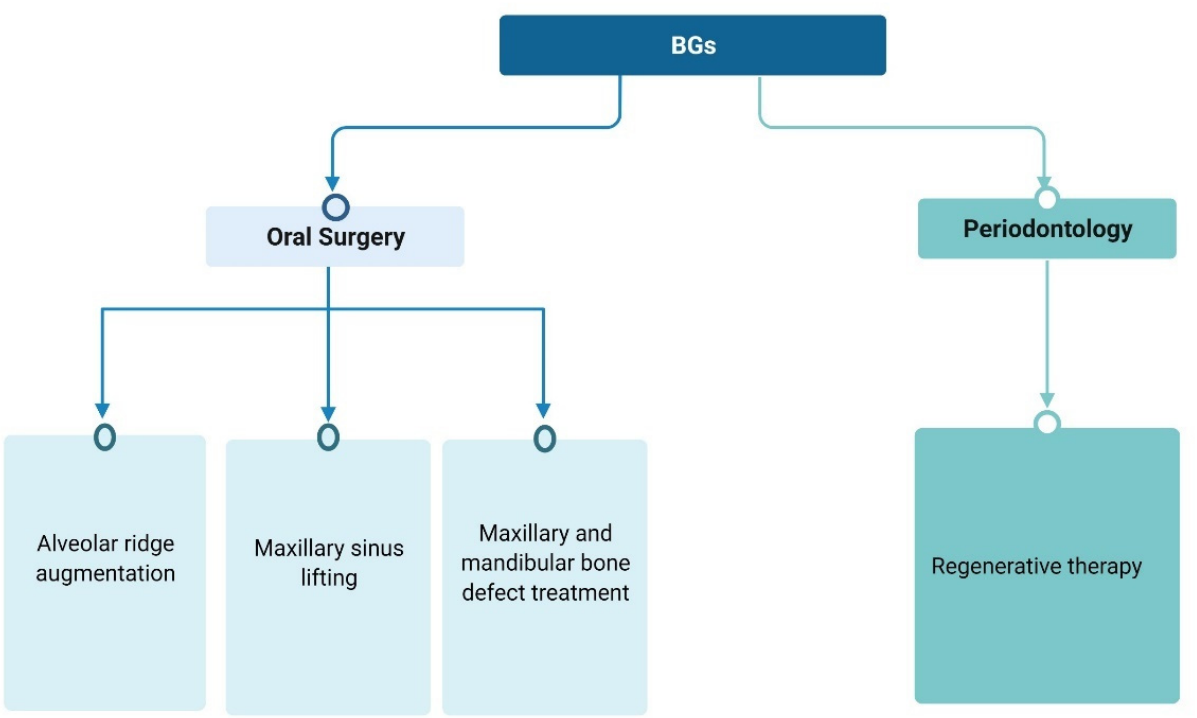
Figure 1. BGs use as regenerative surgical treatment in dentistry.